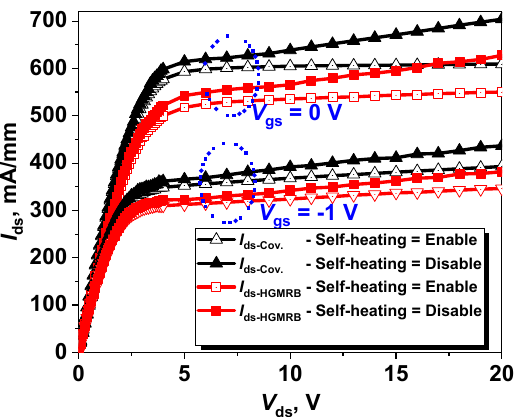
Figure 2. Output characteristics under different values of gate bias for the conventional HEMT and HGMRB HEMT including self-heating.